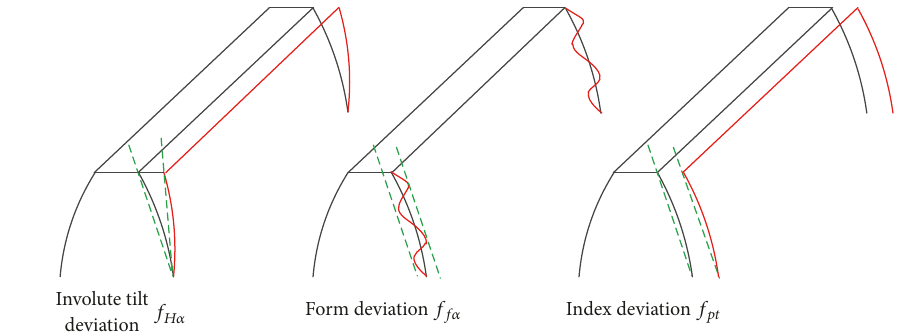
Figure 3: Diagrams of PE and IE.